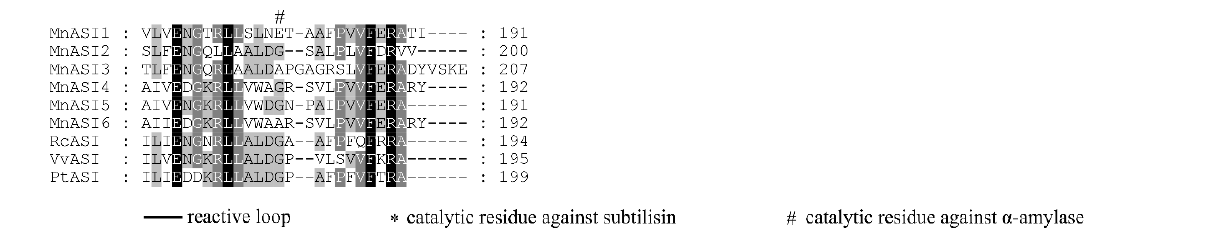
Figure 1. Multiple sequence alignment of MnASIs with other α -amylase/subtilisin inhibitors. A solid line indicates the reactive loop. An asterisk shows the catalytic residue against subtilisin. A pound sign shows the catalytic residue against α -amylase. The accession numbers obtained from GenBank are as follows: RcASI ( Ricinus communis , XP_002525871), VvASI ( Vitis vinifera , XP_002265535), and PtASI ( Populus trichocarpa , XP_006383817). The protein sequences of other plant α -amylase/subtilisin inhibitors obtained from NCBI were multiple aligned. Phylogenetic and molecular evolutionary analyses were per- formed using MEGA 6 to explore the evolutionary relationships among different species (Figure 2). The results showed that the MnASIs proteins of mulberry clustered together and were more distantly related to the α -amylase/subtilin inhibitors in Aegilops tauschii , Hordeum vulgare , and Brachypodium distachyon , and were more closely related to the α - amylase/subtilin inhibitors in Vitis vinifera and Citrus sinensis .